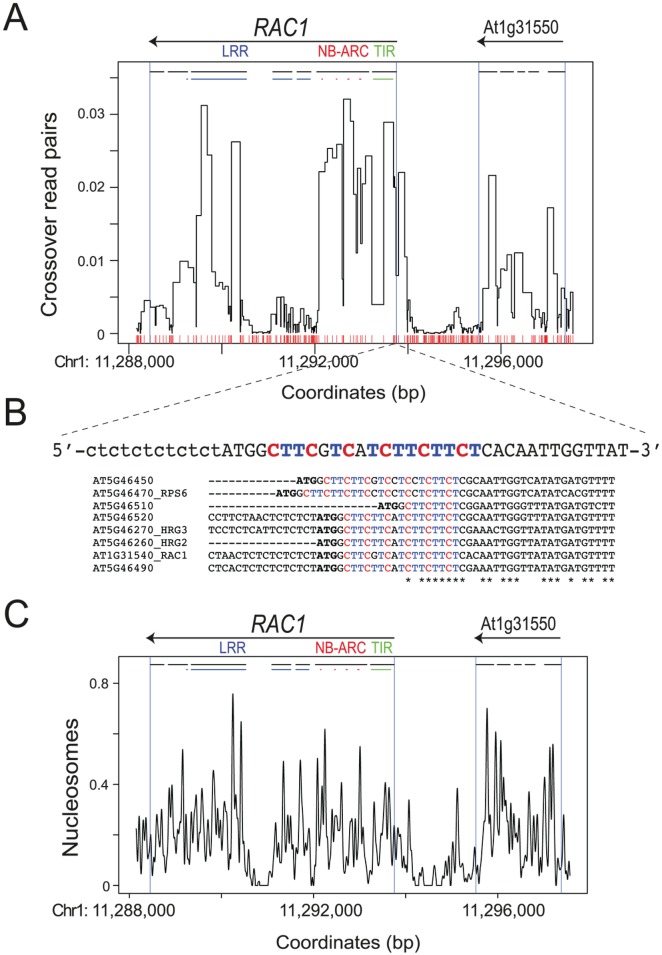
RAC1 crossovers measured by high-throughput sequencing, nucleosome occupancy and CTT-repeat motifs.(A) Normalized crossover read pair values are plotted relative to the TAIR10 reference sequence, with the position of Col/Ler polymorphisms indicated by red x-axis ticks. Labelling is as for Fig 3C. (B) The sequence of the RAC1 CTT-repeat motif is printed and connected to its physical location in (A) with dashed lines. Note the sequence is the reverse complement relative to the orientation of plotting in (A). The presence of CTT-motifs in RAC1-related paralogs in the Col-0 accession are shown in a multiple sequence alignment, where gene start codons (ATG) are in bold type. The asterisks beneath the alignment indicate identical positions. (C) Normalized nucleosome occupancy values (MNase-seq) plotted as for (A).